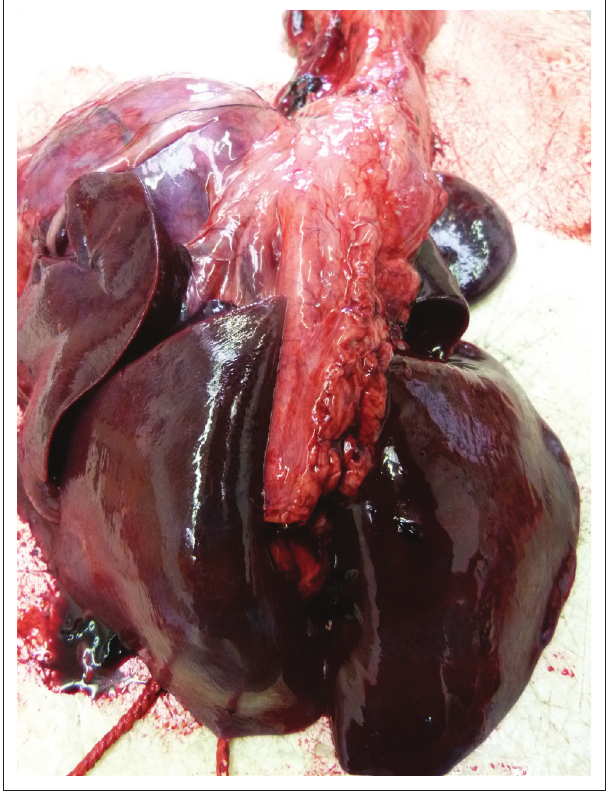
Source : Image taken by June H. Williams during the necropsy FIGURE 2: Dorsal view of dog lungs showing diffuse extreme dark congestion, oedema, lack of aeration and liver-like appearance: paraquat